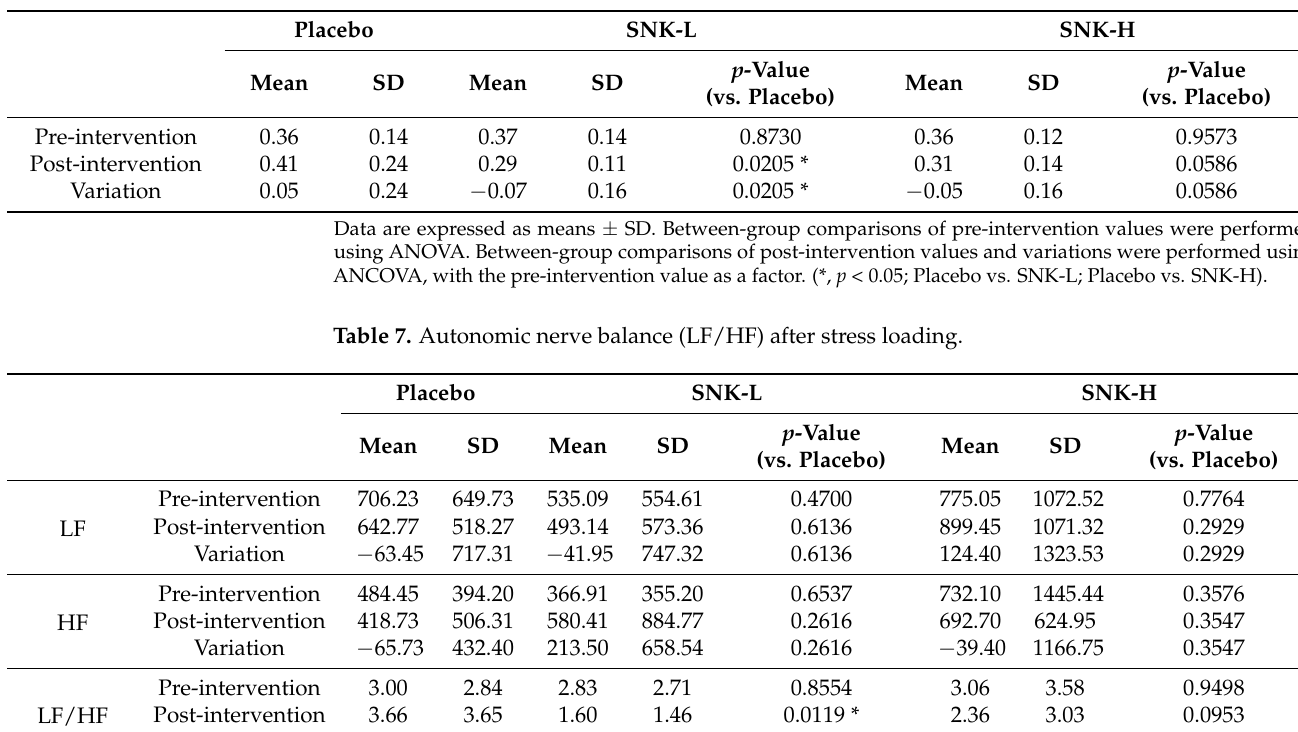
Table 6. Salivary cortisol levels after stress loading.